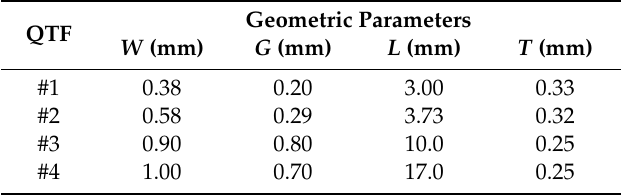
Table 1. The geometric parameters of four different QTFs. W, L, and T are the prong width, length, and thickness, respectively, as defined in Figure 1a. g is the spacing between two prongs. Geometric Parameters QTF W QTF